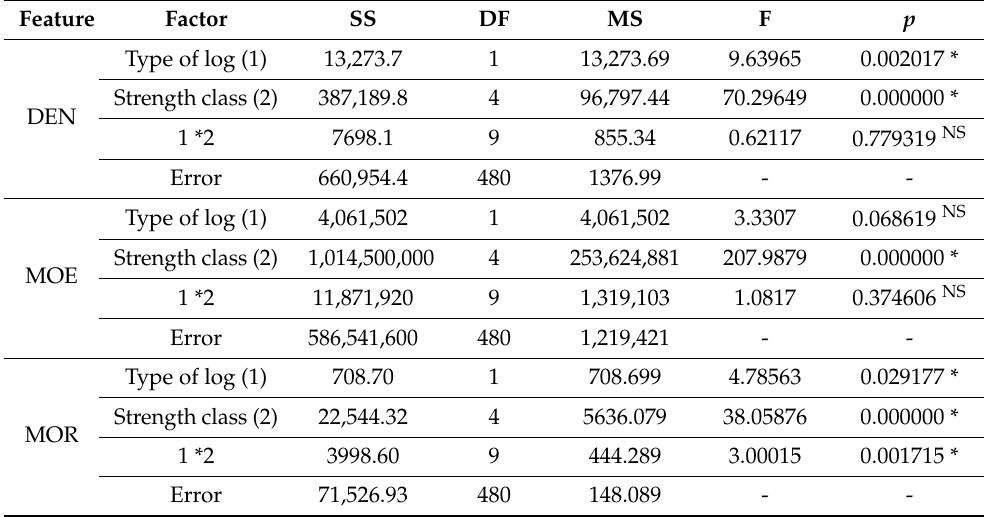
Table 2. Values of ANOVA for density, MOE and MOR, depending on the type of log and assigned strength class.